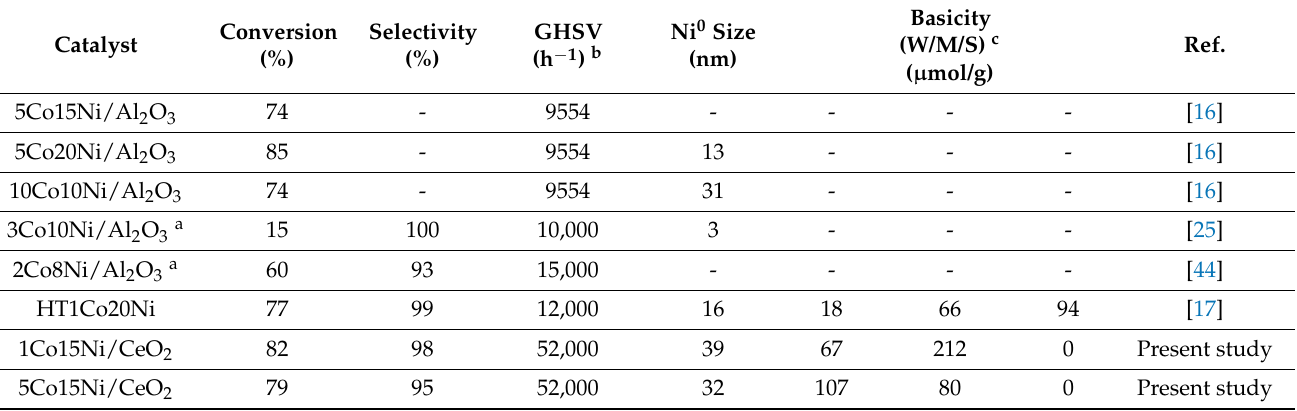
Table 5. Comparison between Ni-Co catalysts with different supports (conversion and selectivity are all considered at 300 ◦